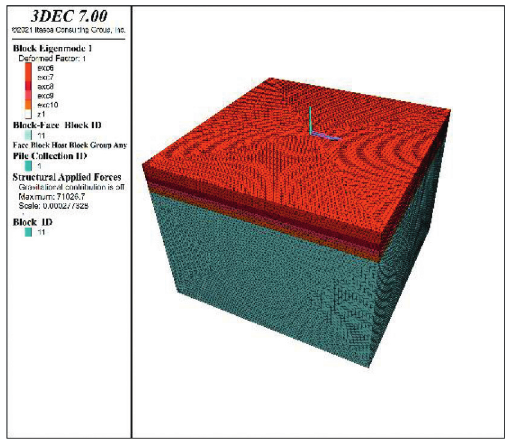
Figure 8: Force calculation model based on numerical